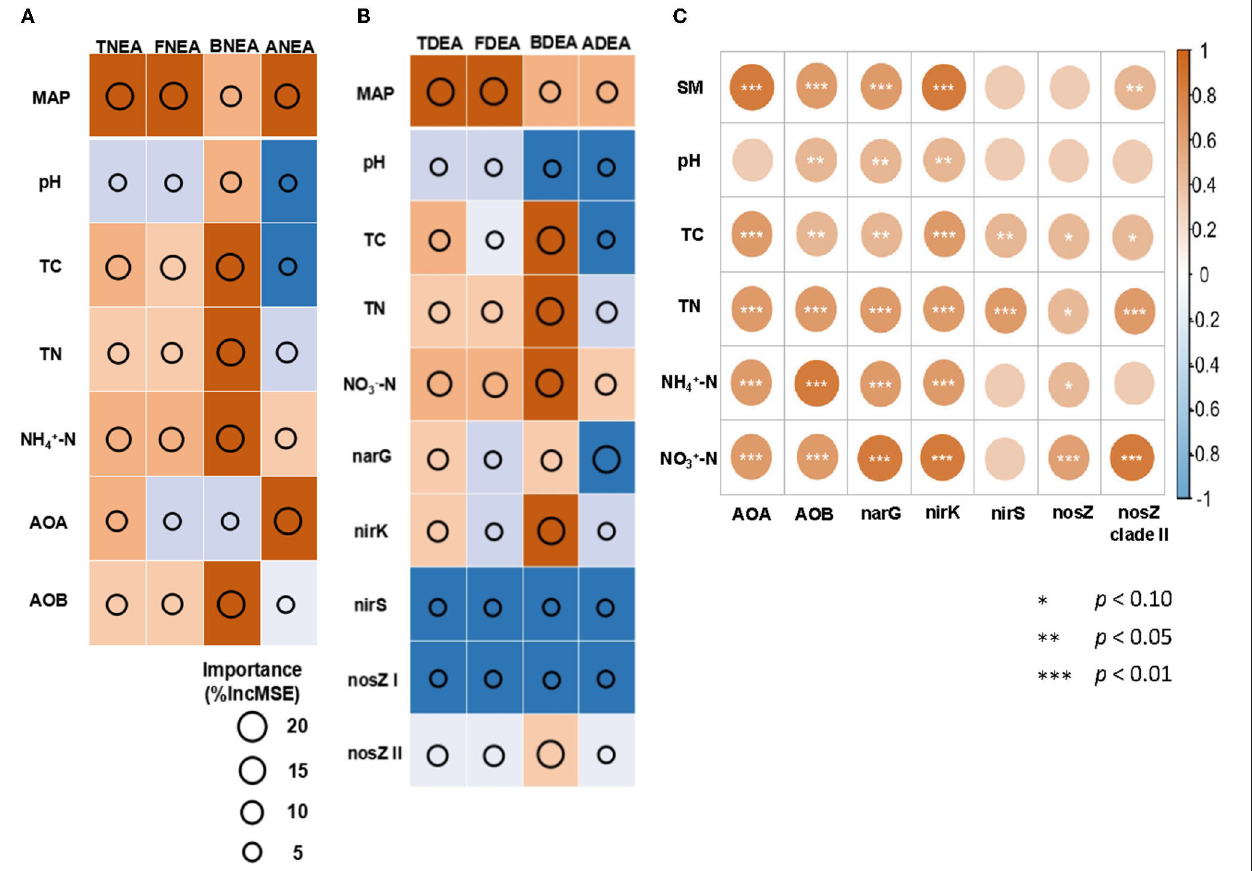
FIGURE 3 | Random forest (RF) models to identify the significant environmental factors and the abundance of nitrification genes controlling TNEA, FNEA, BENA, and ANEA (A) ; the abundance of denitrification genes controlling TDEA, FDEA, BDEA, and ADEA (B) . The relationships between the physical and chemical properties of the soil and gene abundance (C) . The importance is calculated as the percentage (%) increase in the mean square error in RF models (%IncMSE). For (A,B) , the size of the circles indicates the importance of the environmental factors or the gene abundance for TNEA and TDEA. The text colored in orange represents adjusted p < 0.05; in blue represents adjusted p > 0.05, with the darker color indicating the lower or higher p -value, respectively. For (C) , the color shade indicated the coefficients of determination, * indicates p < 0.10, ** indicates p < 0.05, and *** indicates p <